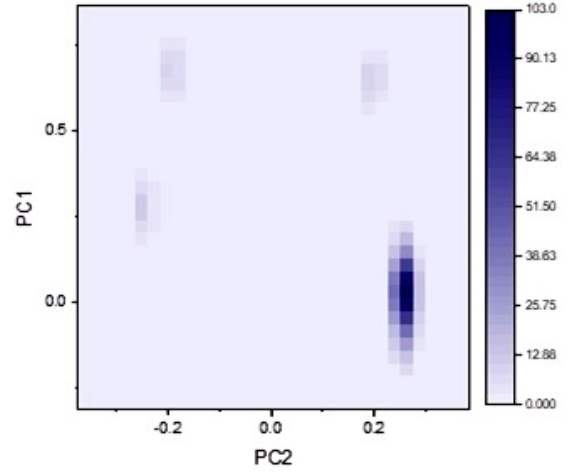
Figure 4. Heat map showing density clustering of all retention factors for thiazole chalcone and flavone derivatives. One main cluster is observed consecutively with three minor